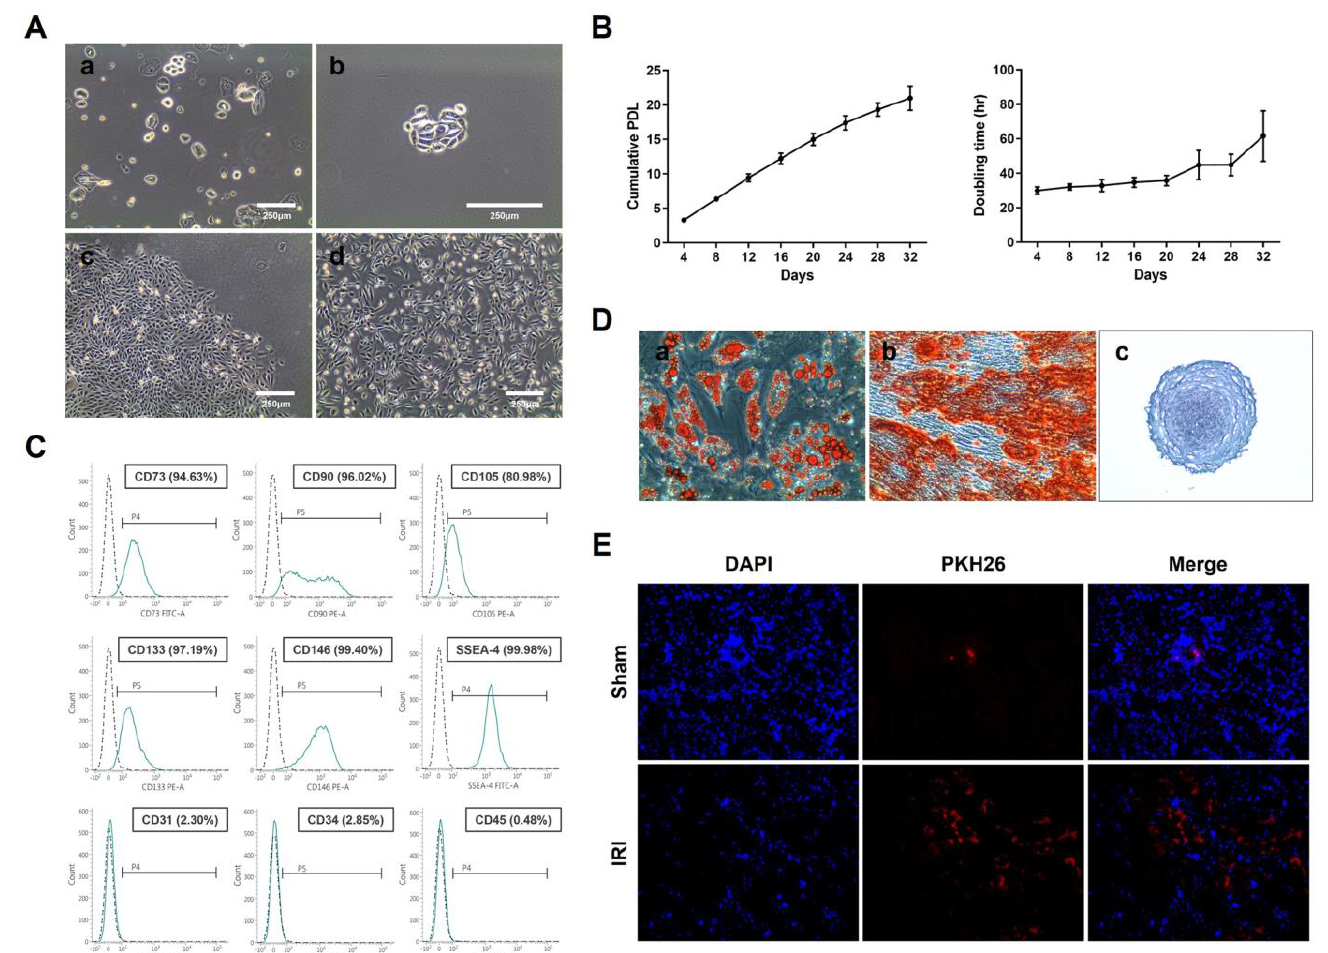
Figure 1. Characterization and homing effect of UDSCs. ( A ) Isolation and culture of UDSC. ( a ) Non-adherent cells in s fresh urine sample (Day 0). ( b ) Cell attachment (Day 3). ( c ) Colony formation of rice grain-shaped cells (Day 10). ( d ) Morphological changes into spindle-shaped cells (Passage 1). ( B ) Representative growth curve of the UDSCs. ( a ) The cumulative population doubling level (CPDL) and ( b ) doubling time (DT) were analyzed at each passage. ( C ) The representative surface marker expression was detected by flow cytometry at passage 5. ( D ) Multilineage differentiation of UDSCs. ( a ) Adipogenic differentiation; Oil Red O staining for lipid droplets (Day 21). ( b ) Osteogenic differentiation; Alizarin Red S staining for calcium deposits (Day 21). ( c ) Chondrogenic differentiation; Alcian Blue staining for glycosaminoglycan accumulation (Day 21). ( E ) PKH26-labeled UDSCs (red) were intravenously administered to wild-type (Sham) and ischemia-reperfusion injury (IRI) mice.